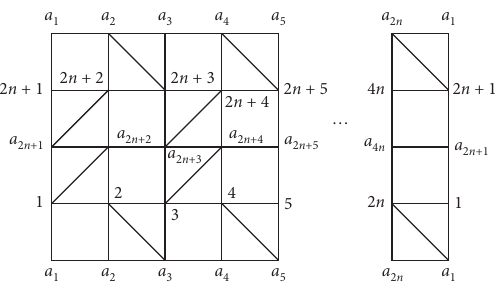
Figure 13: DSEM of type- [ 3 3 , 4 2 : 3 2 , 4 , 3 , 4 ]